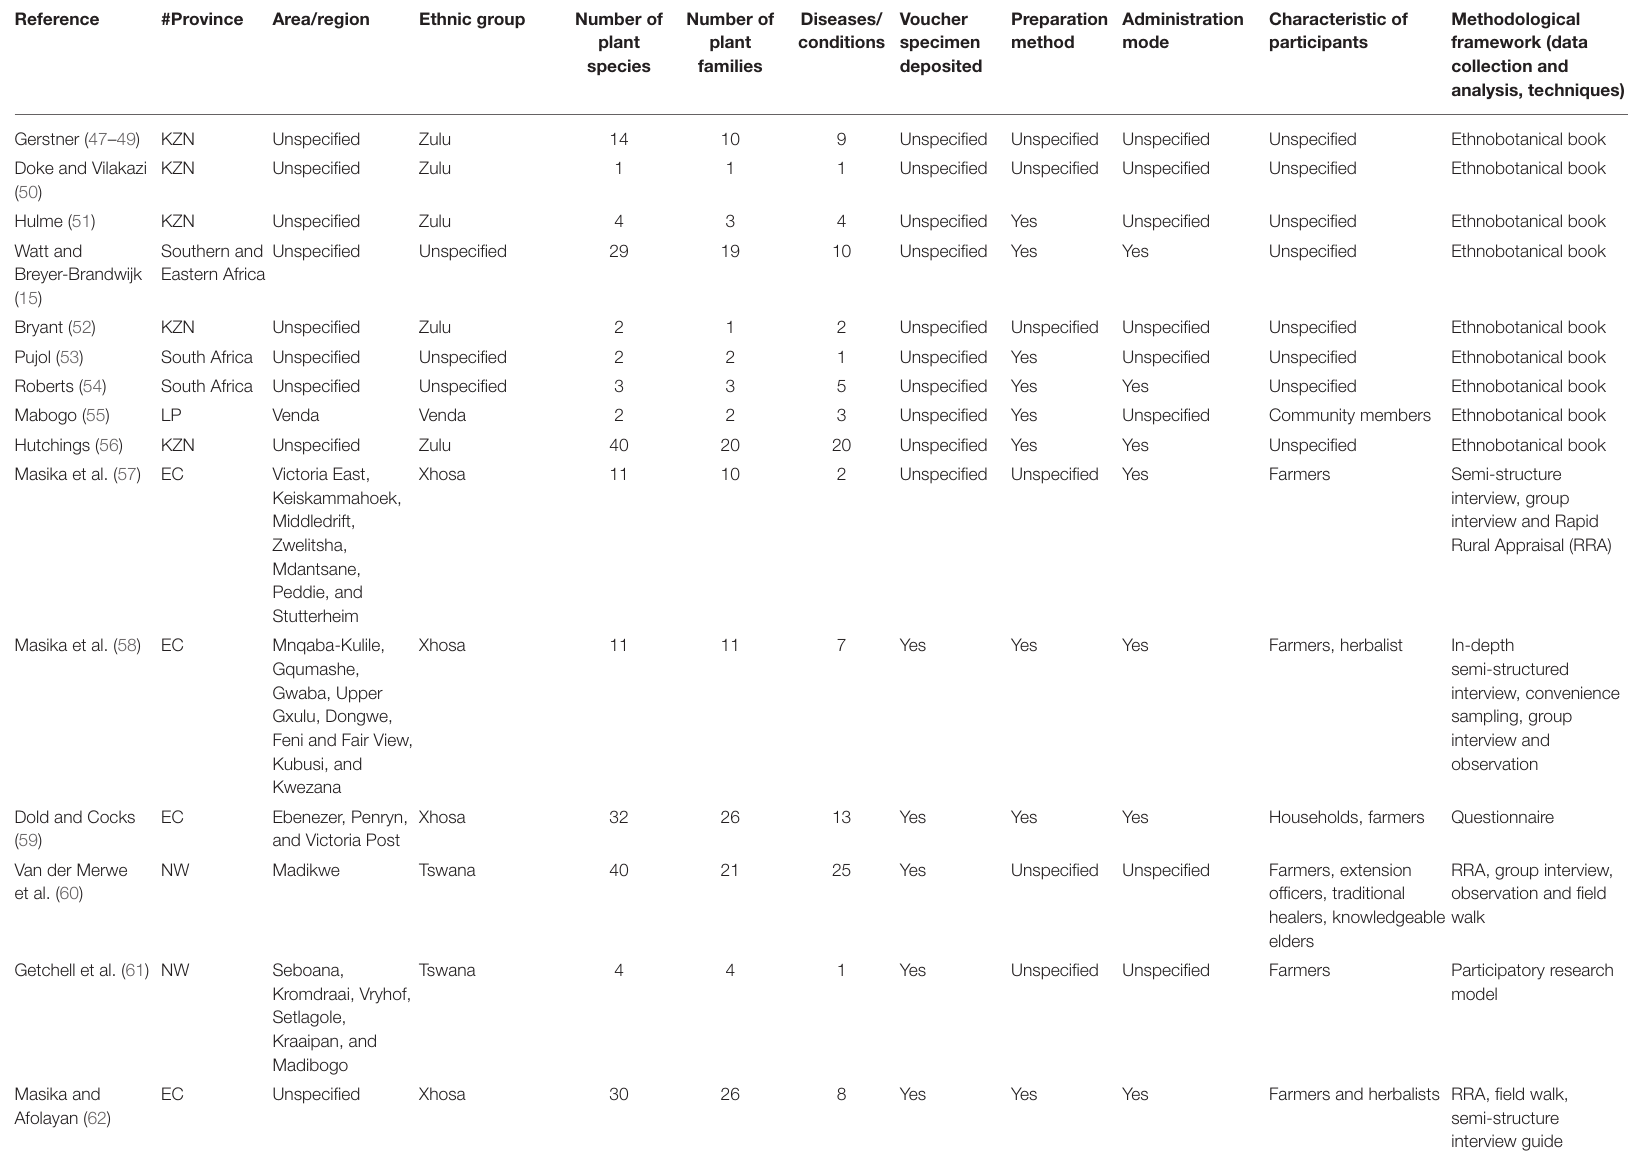
TABLE 1 | An overview of reviewed literature on ethnoveterinary studies on plants used against cattle diseases in South Africa.